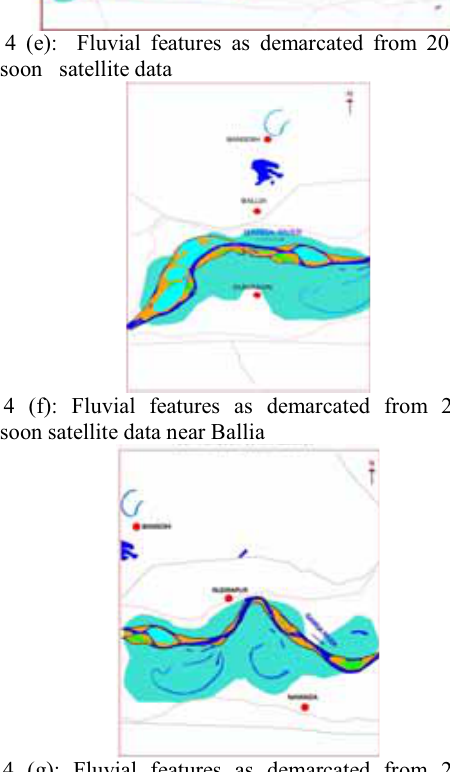
Fig 4 (g): Fluvial features as demarcated from 2006